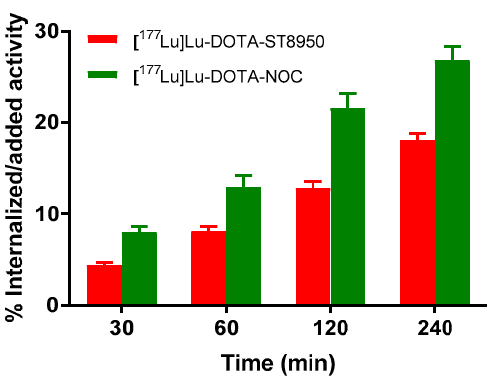
Figure 2. Internalization of [ 177 Lu]Lu-DOTA-ST8950 and [ 177 Lu]Lu-DOTA-NOC in Human Embryonic Kidney (HEK)-SST2 at 37 °C. The results are expressed as % (mean ± SD) of applied activity in the cells and normalized per million cells. All values refer to specific internalization after subtracting the nonspecific (measured in the presence of 1000-fold excess of SS-14) from the total internalized fraction, at each time point.